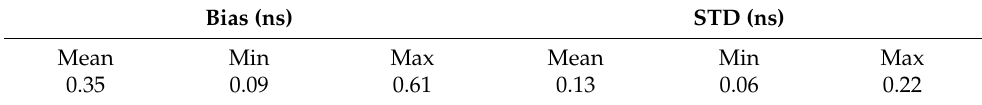
Table 2. Precision statistics of the differential code bias (DCBs) for satellites.